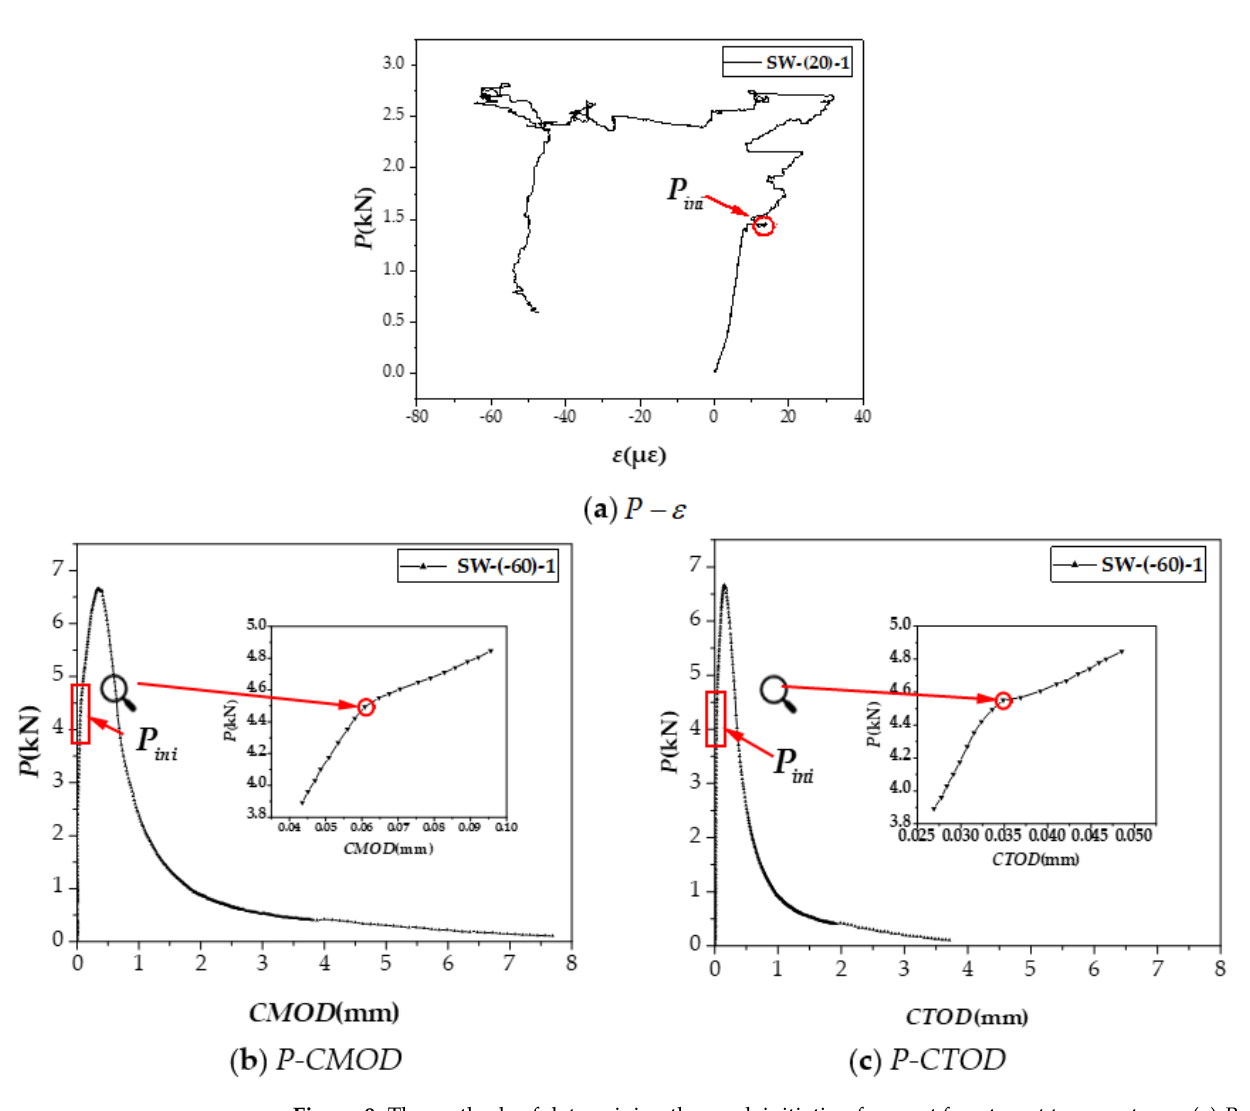
Figure 9. The methods of determining the crack initiation forces at four target temperatures. ( a ) P − ε . ( b ) P-CMOD. ( c ) P-CTOD .